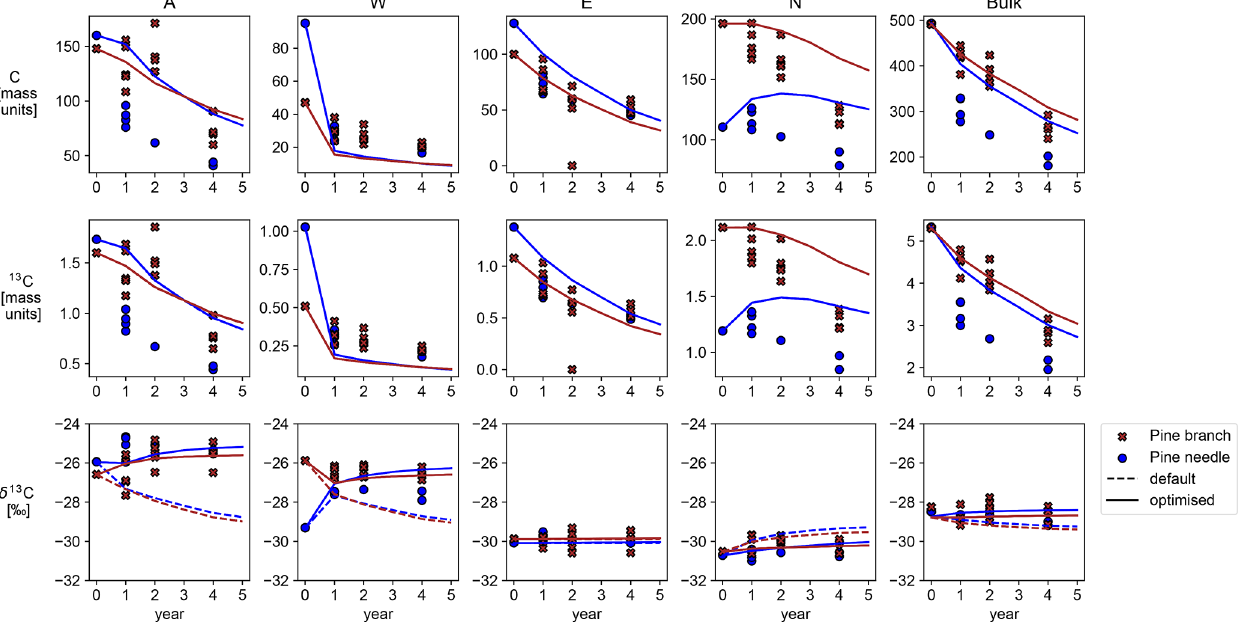
Figure 2. Shown are time series produced by the default and optimised Yasso model versions for the different AWEN pools together with assimilated observations. The model results for C and 13 C concentrations are on top of each